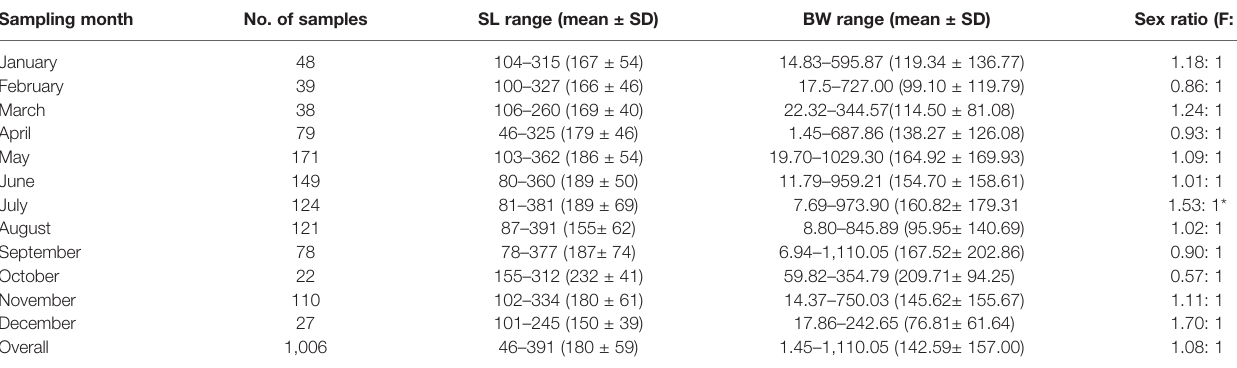
TABLE 2 | The variation of sex ratio, body size (mm), and body weight (g) of Larimichthys crocea collected from April 2019 to November 2021. Sampling month No. of samples SL range (mean ±